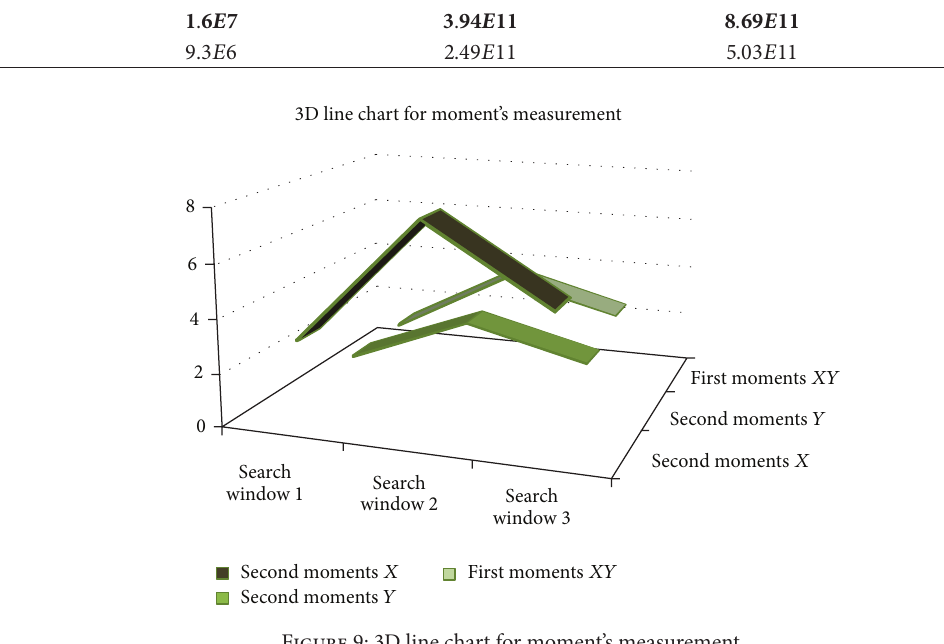
Figure 9: 3D line chart for moment’s